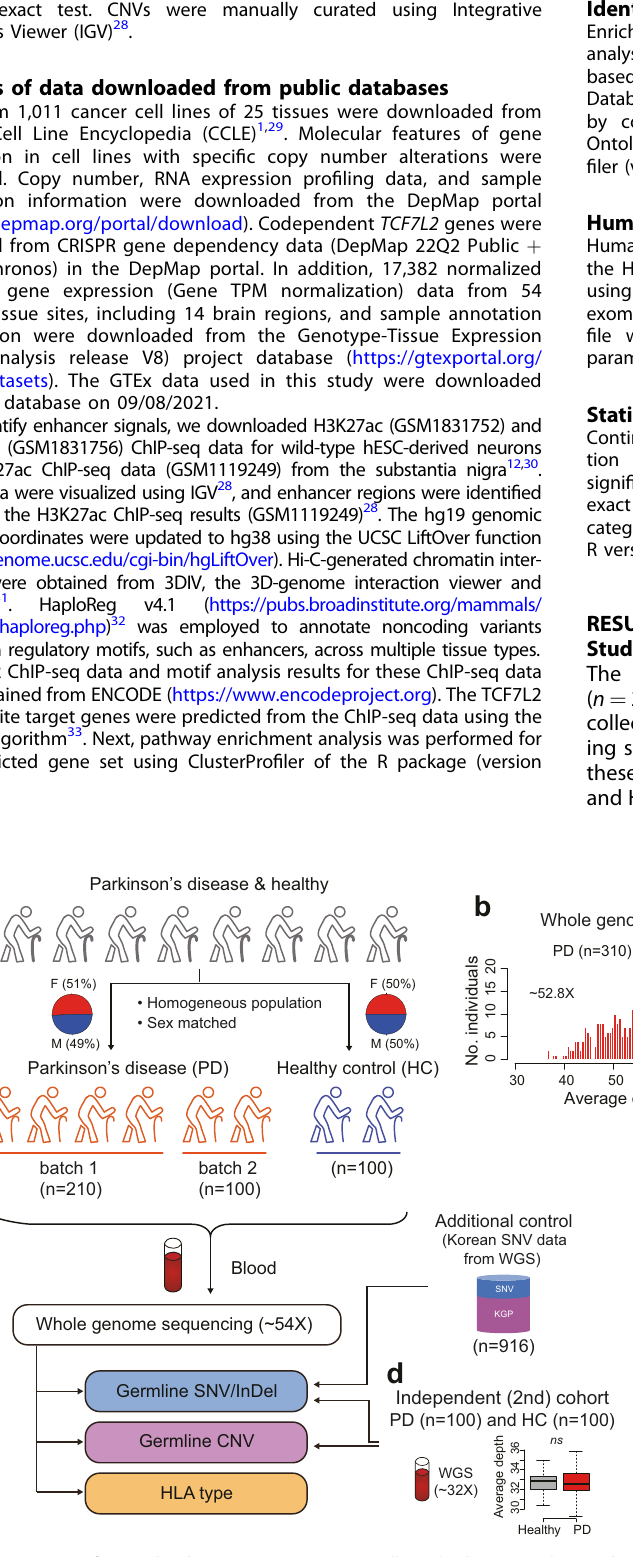
Fig. 1 Summary of sample characteristics. a Overall study design and WGS. b Average sequencing depths of analysis-ready BAM fi les. c Relatively lower read depth of the BAM fi les in the batch 1 PD cohort compared to that in the batch 2 PD cohort (Wilcoxon-rank sum test). d WGS of an independent cohort composed of 100 PD patients and 100 healthy individuals for validation purposes (Wilcoxon-rank sum test). e Age of onset of PD did not differ between PD batches 1 and 2 (Wilcoxon-rank sum test). f Interval between blood sampling and time of onset of PD. g Age distribution of healthy individuals at the time of blood sampling. CNV copy number variation; HC healthy control; PD Parkinson ’ s disease; WGS whole-genome